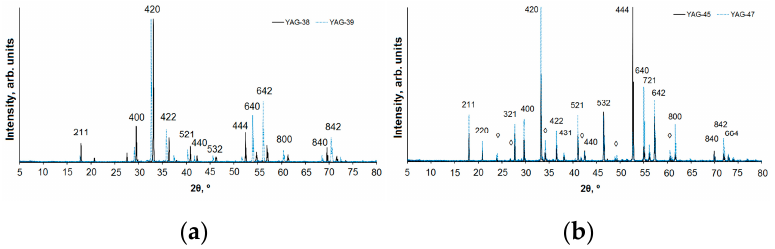
Figure 3. X-ray diffraction patterns of YAG samples: ( a ) 1 (solid line) and 2 (dashed line): ( b ) 3 (solid line) and 4 (dashed line). Reflections belonging to accompanying phases are marked with a ♦ . Table 1. Results of studying the phase composition of the